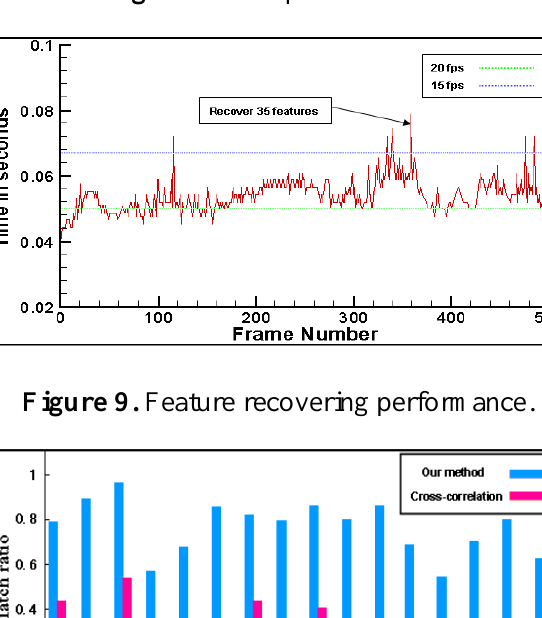
Figure 8. Computation time.